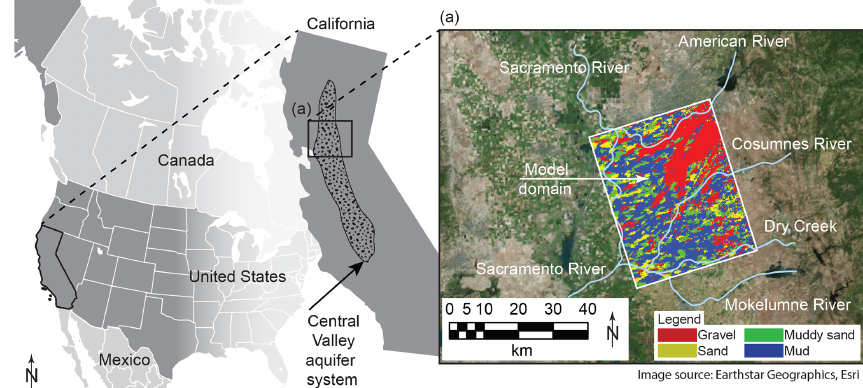
Figure 1. Location of the model domain in the Central Valley aquifer system in California and (a) inset of the uppermost layer of the model hydrofacies overlain over aerial imagery of the Central Valley and local river systems (Maples et al., 2019). Imagery is derived from Earthstar Geographics, copyright © Esri. All rights reserved (https://www.esri.com/en-us/home, last access: 8 April 2020).